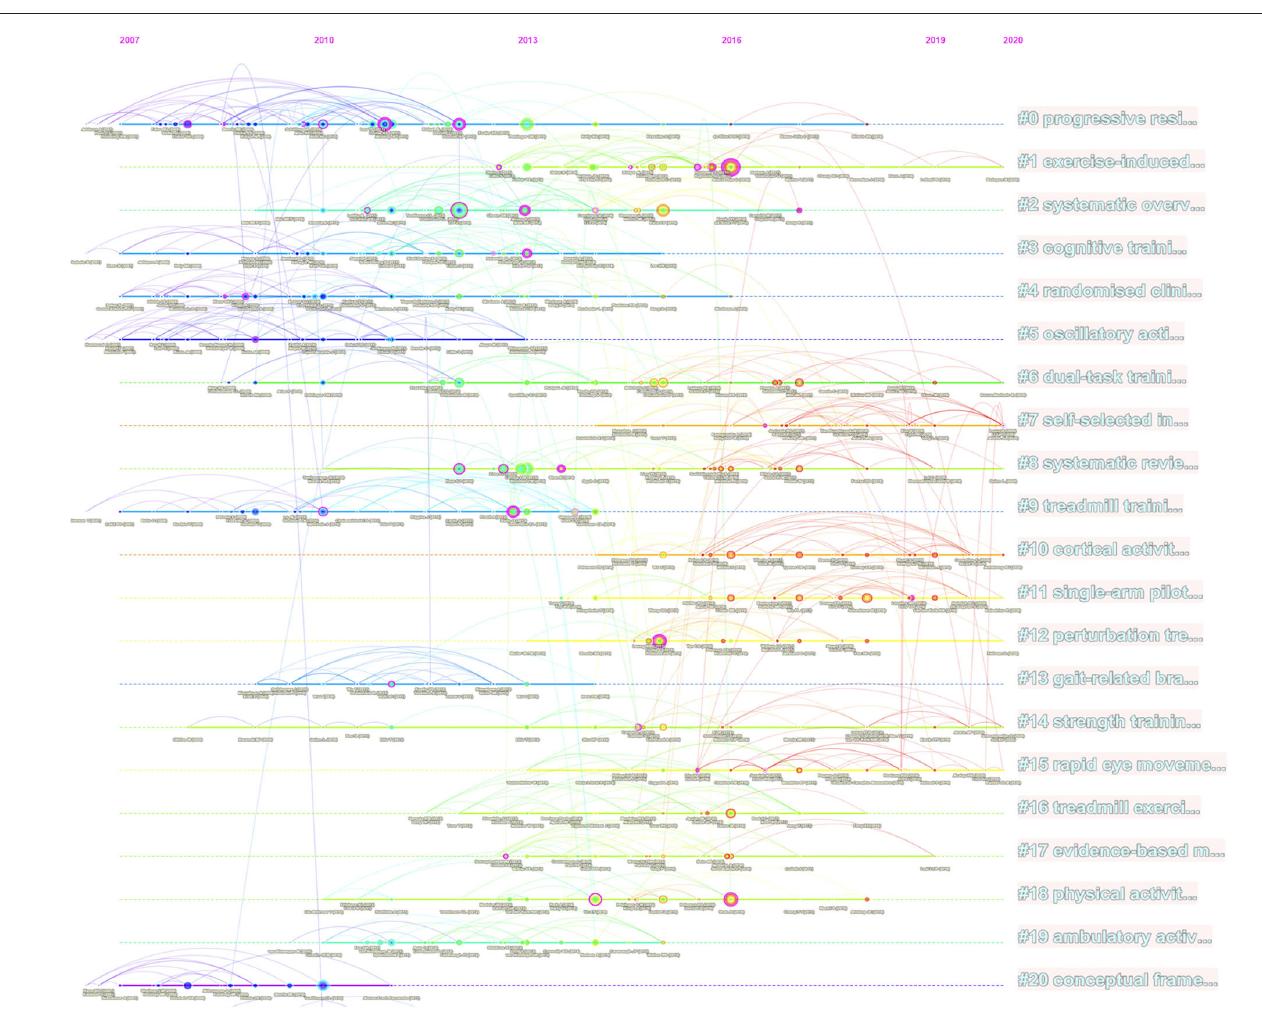
FIGURE 8 | Timeline view map related to exercise on